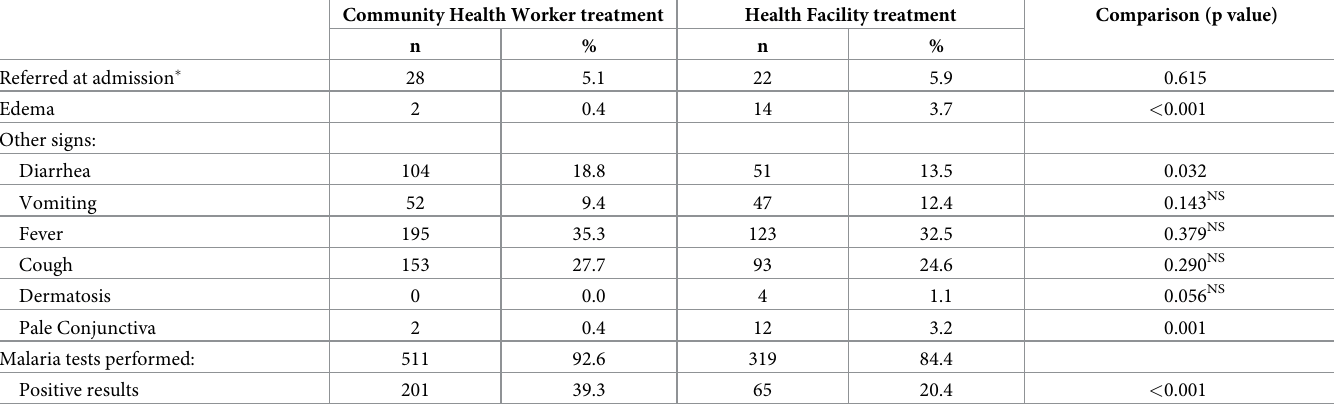
Table 2. Presence of disease signs during the medical assessment at admission according to the two models of outpatient